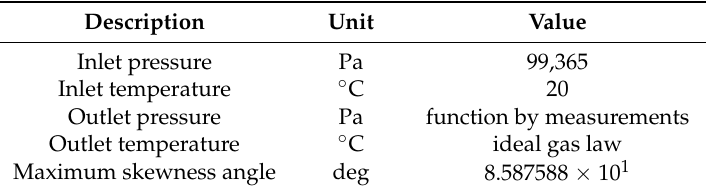
Table 3. Boundary conditions and mesh diagnostics in the present